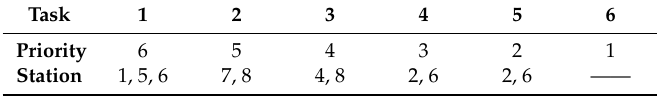
Table 7. Scheduling results of eight stations and six tasks.